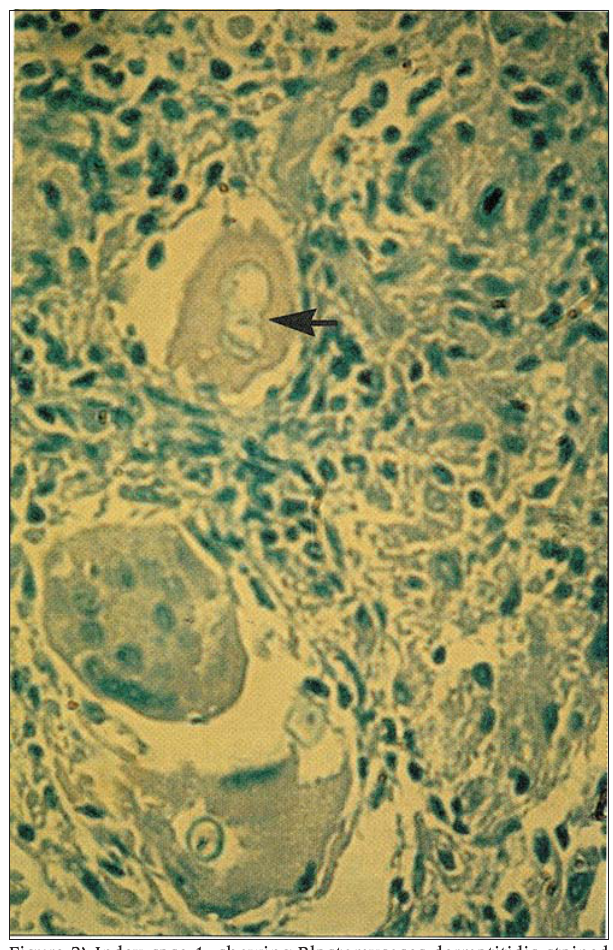
Figure 2) Index case 1, showing Blastomycoses dermatitidis stained with GMS. Pulmonary nodule x